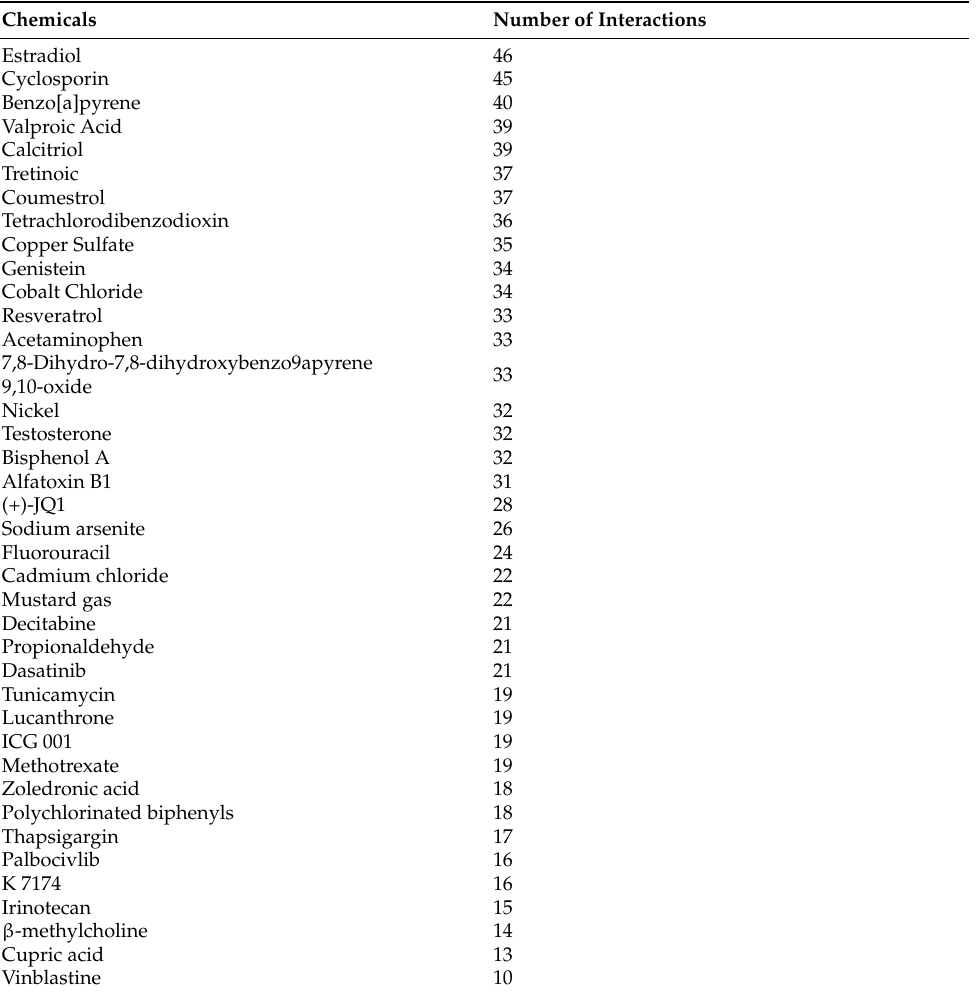
Table 4. Chemicals interacting with 60 genes differentially expressed in breast